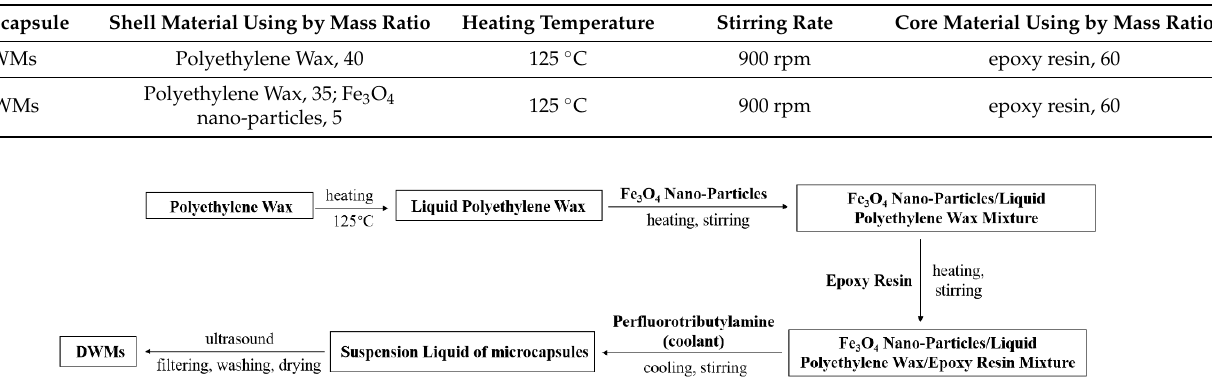
Figure 1. Preparation procedure of DWMs.